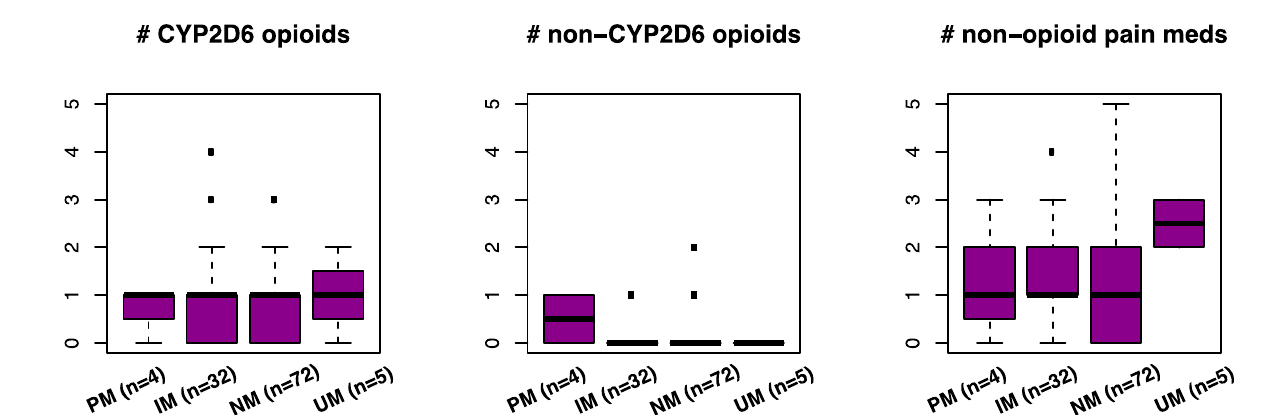
Figure 2. Visualization of the number of medications prescribed at baseline. The left panel displays the number of prescribed baseline opioid pain medications that require CYP2D6 for metabolism, the middle panel displays the number of prescribed baseline opioid pain medications that do not require CYP2D6 for metabolism, and the right panel displays the number of prescribed non-opioid pain medications. PM denotes poor metabolizer, IM denotes intermediate metabolizer, NM denotes normal metabolizer, and UM denotes ultra-rapid metabolizer. Each plotted box ranges from the 25th to the 75th percentile of the distribution. Whiskers extend in either direction to 1.5 times the interquartile range from each end of the box, or to the most extreme data point, whichever is less extreme.